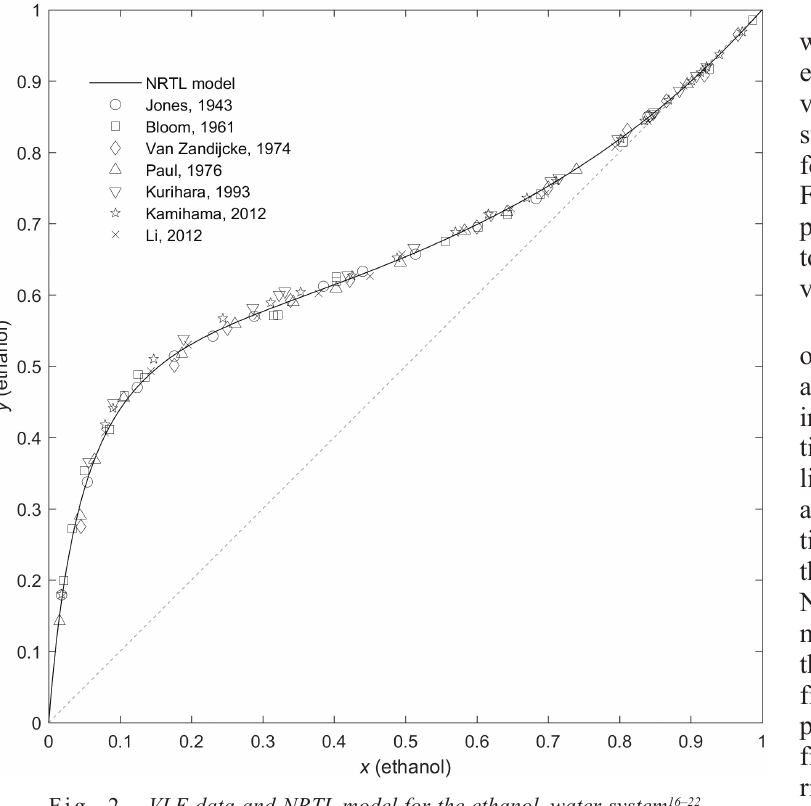
Fig. 2 – VLE data and NRTL model for the ethanol–water system 16–22